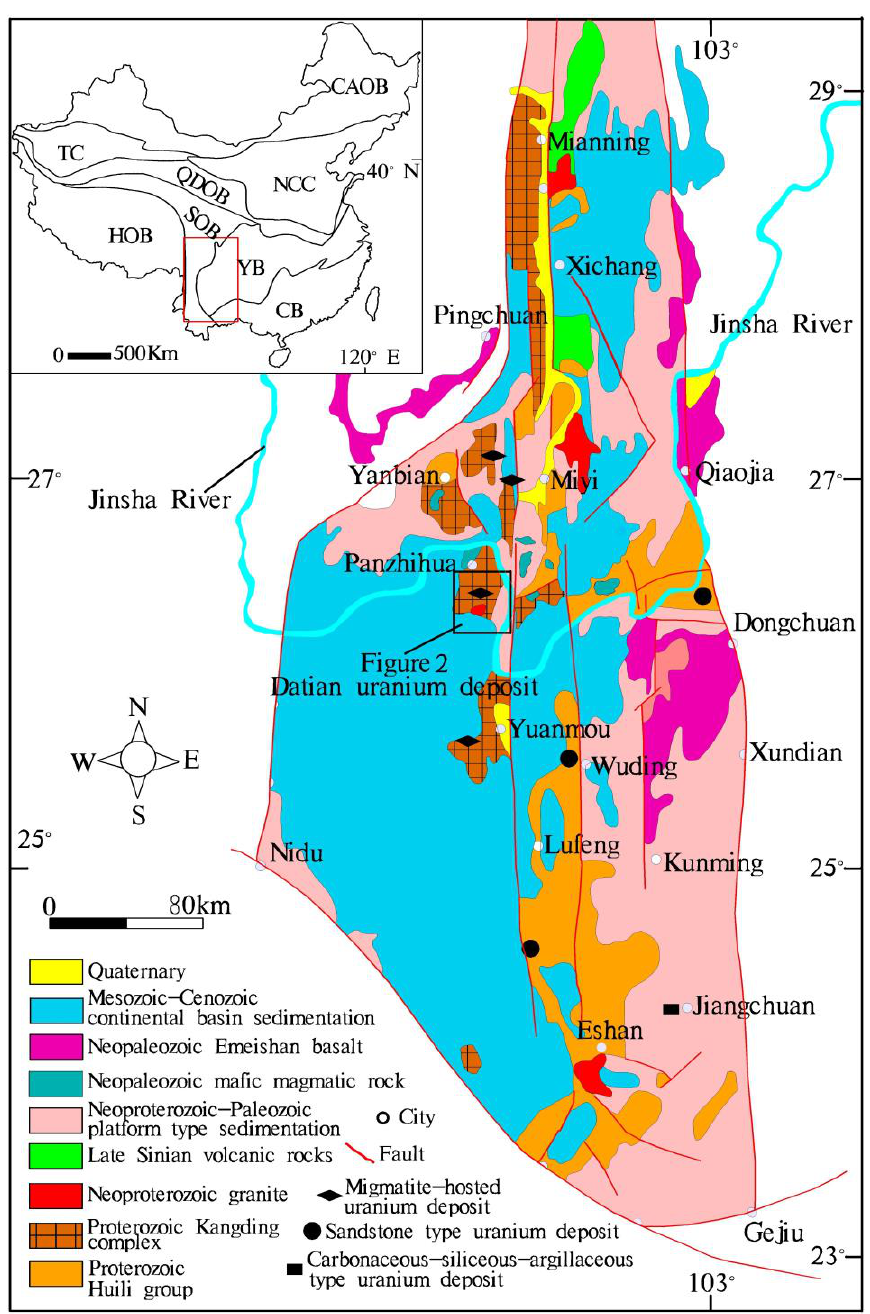
Figure 1. Simplified geologic map of the Kangdian region in the southwestern margin of the Yangtze Simplified geologic map of the Kangdian region in the southwestern margin Block showing the distribution of the Kangding complex (modified from Zhang et al. [12]). CAOB of the Yangtze Block showing the distribution of the Kangding complex (modified from = central Asian orogenic belt, HOB = Himalayan orogenic belt, TC = Tarim Craton, QDOB = Qinling- Zhang et al. [12]). CAOB = central Asian orogenic belt, HOB = Himalayan orogenic belt, TC = Tarim Dabie orogenic belt, YB = Yangtze Block, NCC = North China Craton, CB = Cathaysian Block, SOB Craton, QDOB = Qinling-Dabie orogenic belt, YB = Yangtze Block, NCC = North China Craton, = Sanjing orogenic belt. CB = Cathaysian Block, SOB = Sanjing orogenic